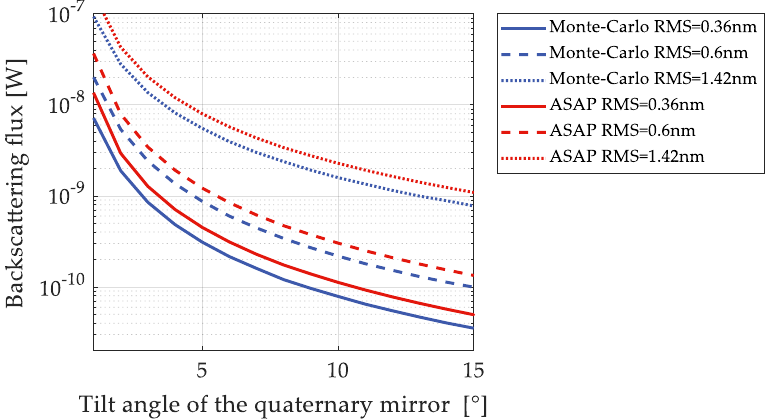
Figure 8. Backscattering flux as a function of tilt angle for reflective spherical cap with different roughness. The blue curves are the calculation with Monte-Carlo method and the red curves are for ASAP results.